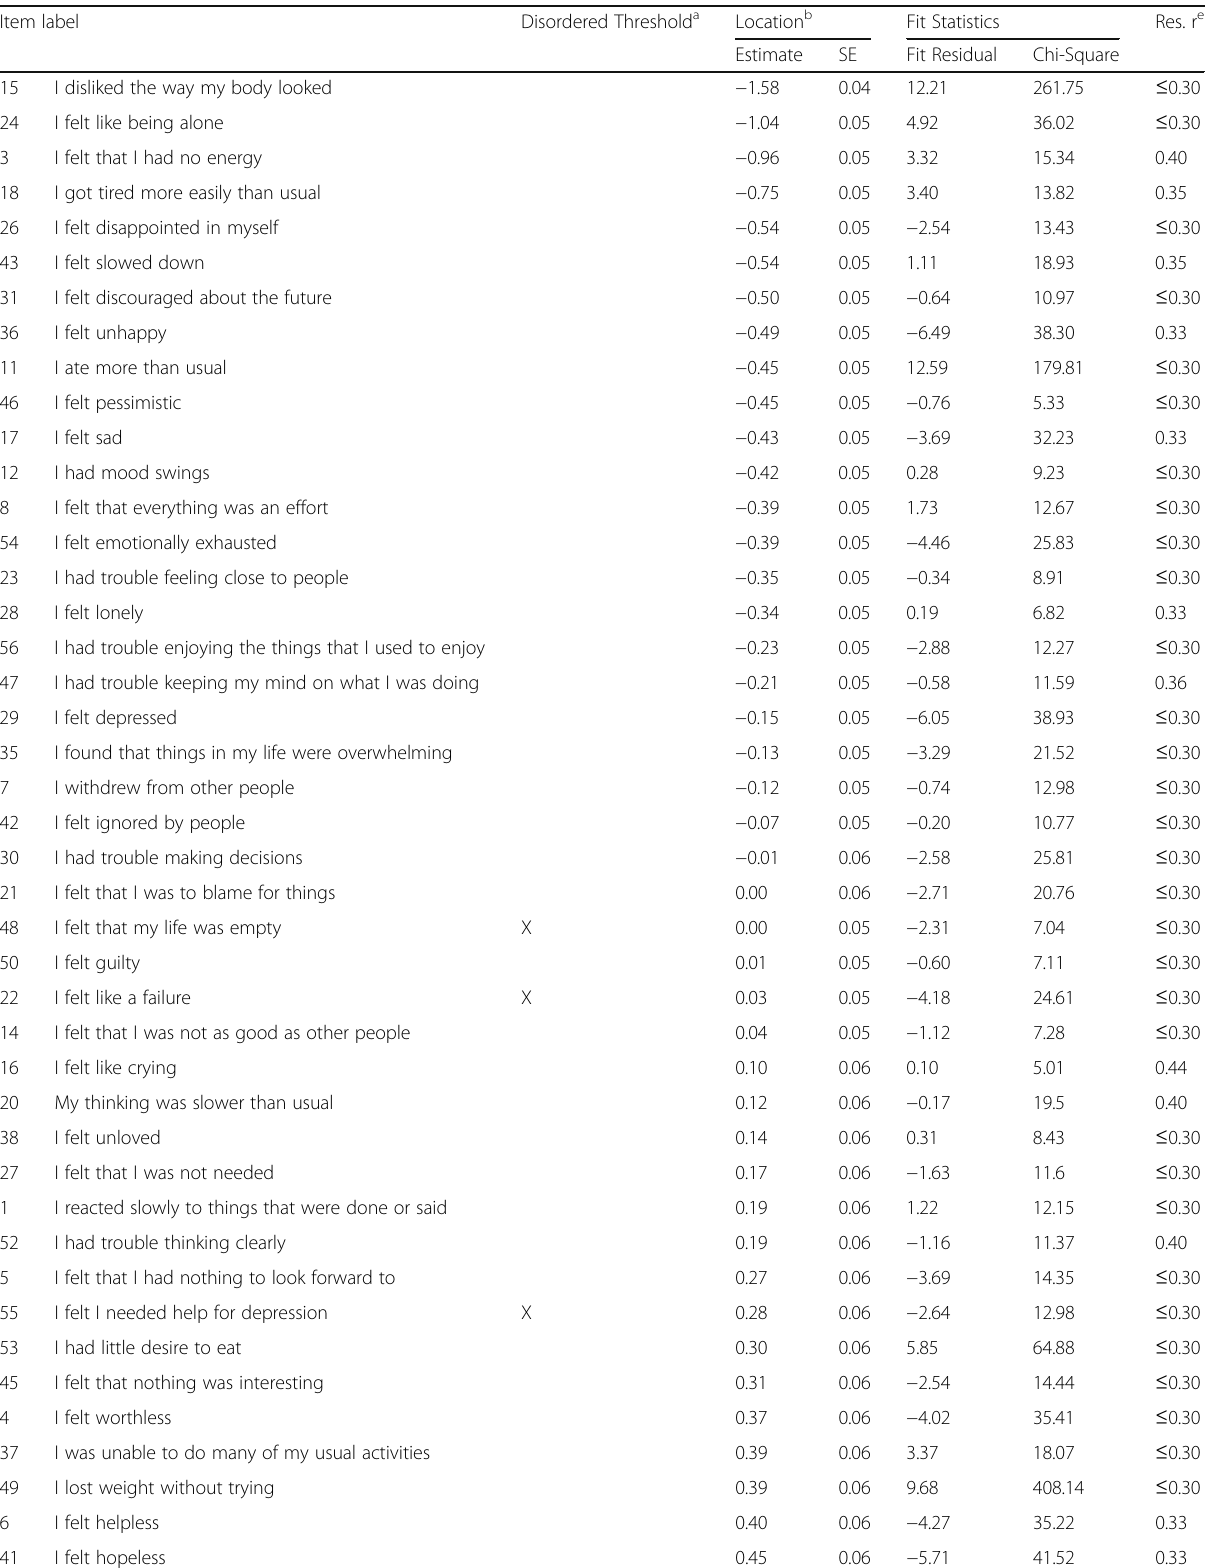
Table 2 PROMIS 51 Thresholds ordering, item location estimates, item fit statistics and item dependency (items ordered by